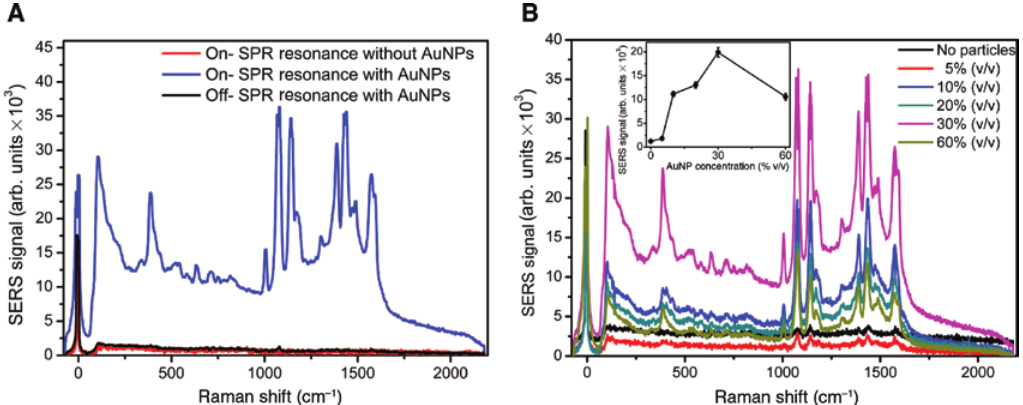
Figure 19: SERS under ultrahigh enhancement with prism configuration. SERS spectra (A) for on ESP resonance at Ag/4ATP configuration and on and off ESP resonances at the optimum Ag/4ATP/AuNP structure and (B) from the Ag/4-ATP/80 nm AuNP structure with varying AuNP solution concentrations. The inset shows the variation of SERS peak signal at 1077 cm −1 with AuNP concentration. Excitation wavelength is 785 nm. Reproduced with permission from